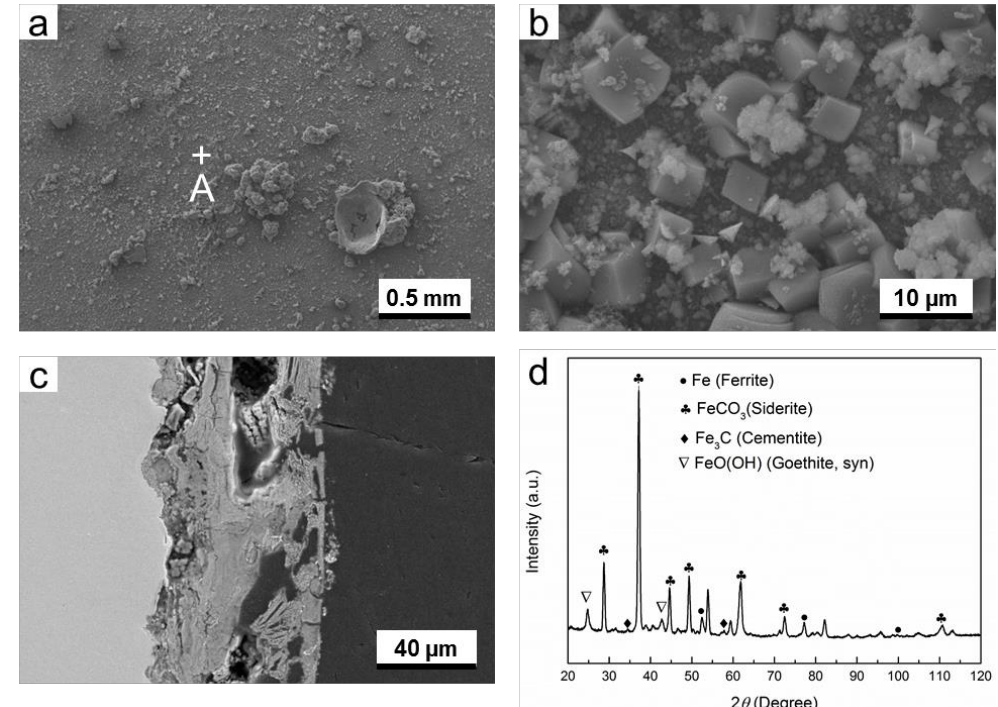
Figure 5. The characterization of corrosion products on G20 steel in liquid phase in O 2 -containing environment: ( a ) SEM image of the surface of corrosion products; ( b ) the higher magnification of region A marked in ( a ); ( c ) corrosion-sectional image of corrosion products layer, and ( d ) XRD pattern of the corrosion products.